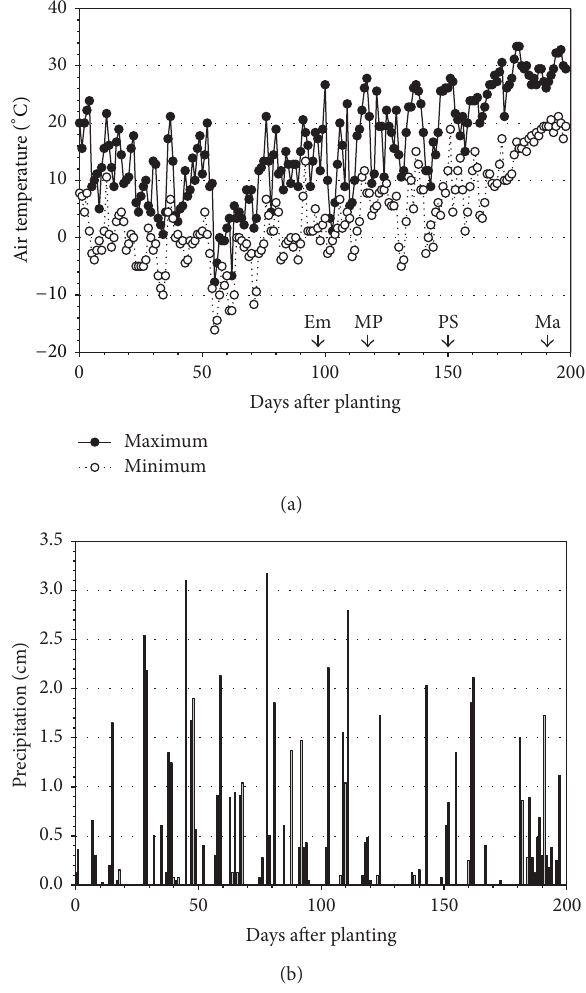
Figure 1: Maximum and minimum daily air temperatures and total daily precipitation measured at 2m elevation from planting to the final harvest for Raleigh, NC. The arrows indicate the dates of shoot emergence (Em), minimum plant (MP) dry matter, peak shoot (PS) dry matter, and bulb maturity